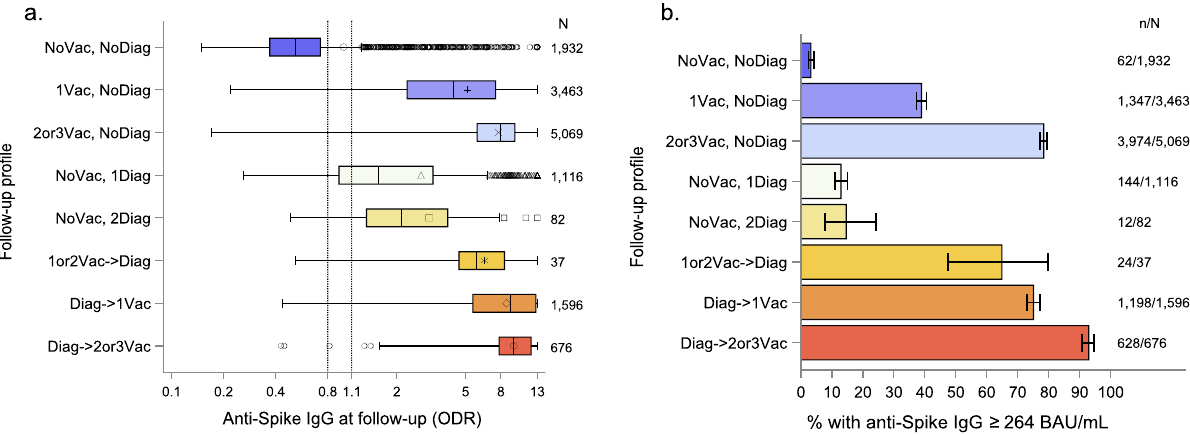
Figure 1. Distribution (boxplot) of anti-spike IgG (ODR) according to follow-up profiles. ( a ) Anti-spike IgG (ODR). The dashed lines show the threshold values for a positive (≥ 1.1), indeterminate [0.8–1.1[ or negative